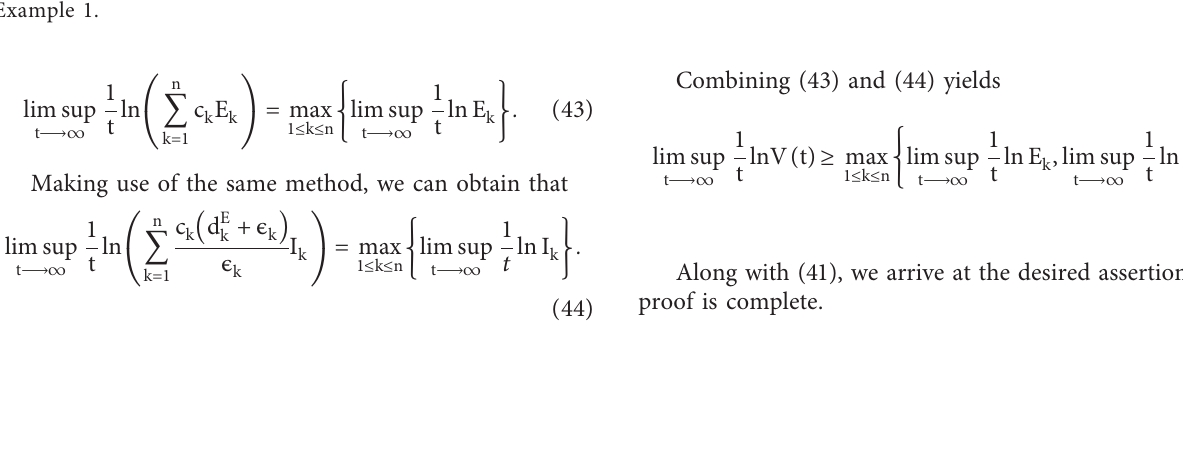
< 1 and initial value S 0